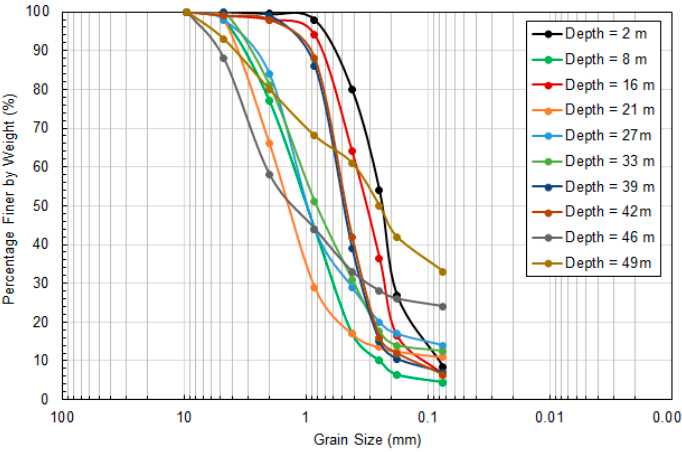
Figure 8. Sieve test and grain number for the Al-Khobar site.